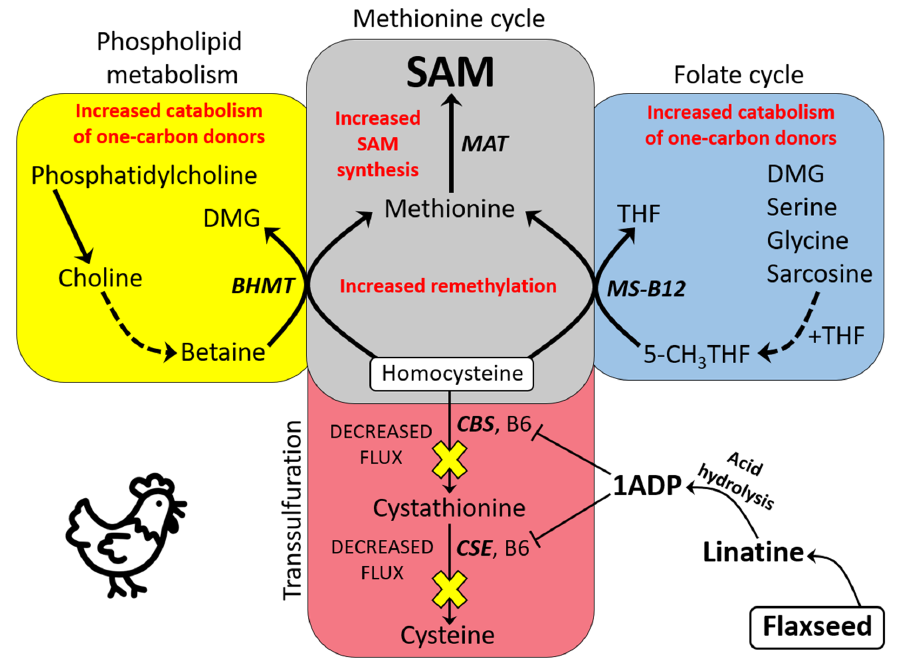
Figure 8. Basic model illustrating how flaxseed increases SAM synthesis in laying hens (predomi- nantly a hepatic model). The initial effect is instigated when 1ADP (via linatine) antagonizes vitamin B6 and reduces CBS and CSE activity. In turn, this reduces carbon flux through transsulfuration and causes cystathionine trapping. Instead of developing HHcy, these animals display increased Hcy remethylation (via BHMT and MS-B12). BHMT hyperactivation induces elevated oxidation of choline and betaine, and MS-B12 hyperactivation induces elevated oxidation of molecules such as DMG and serine. The excess Met produced by the hyperactivation of BHMT and MS-B12 is then adenosylated via MAT to form an excess supply of SAM. In this manner, the SAM level and the SAM:SAH ratio of the hen will rise. 1ADP = 1-amino D -proline; 5-CH 3 THF = 5-methyl tetrahy- drofolate; BHMT = betaine homocysteine methyltransferase; CBS = cystathionine beta